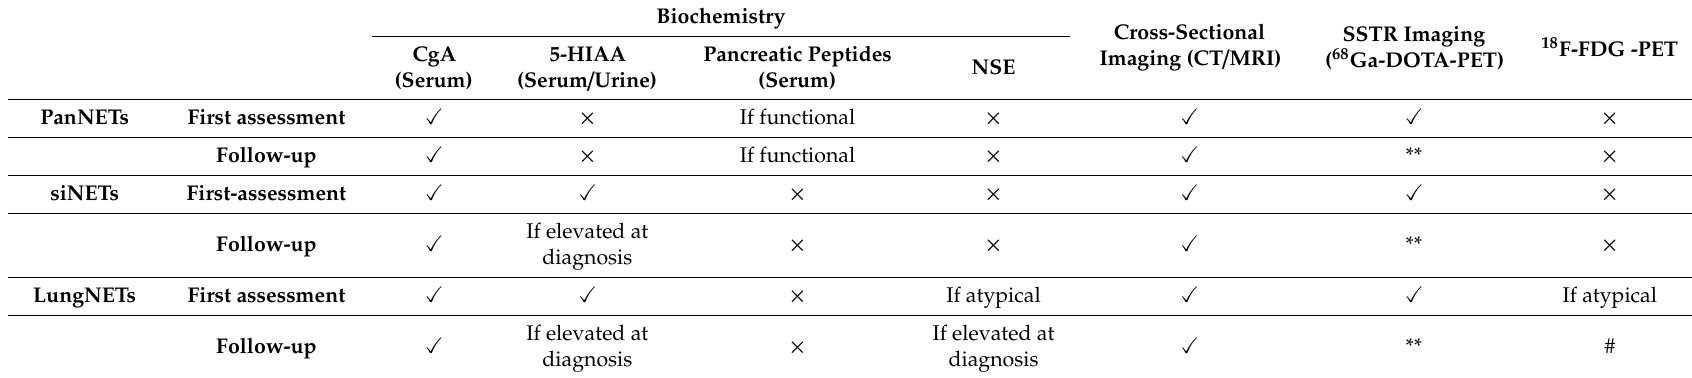
Table 2. Summary recommendations of baseline and follow-up tools in assessment of patients after curative resection of neuroendocrine tumours. Adapted from [11,18–21].